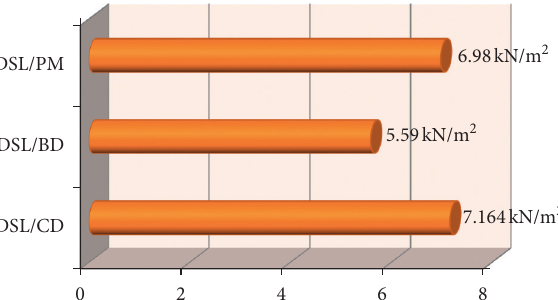
Figure 4: DD of the briquettes with different binders.